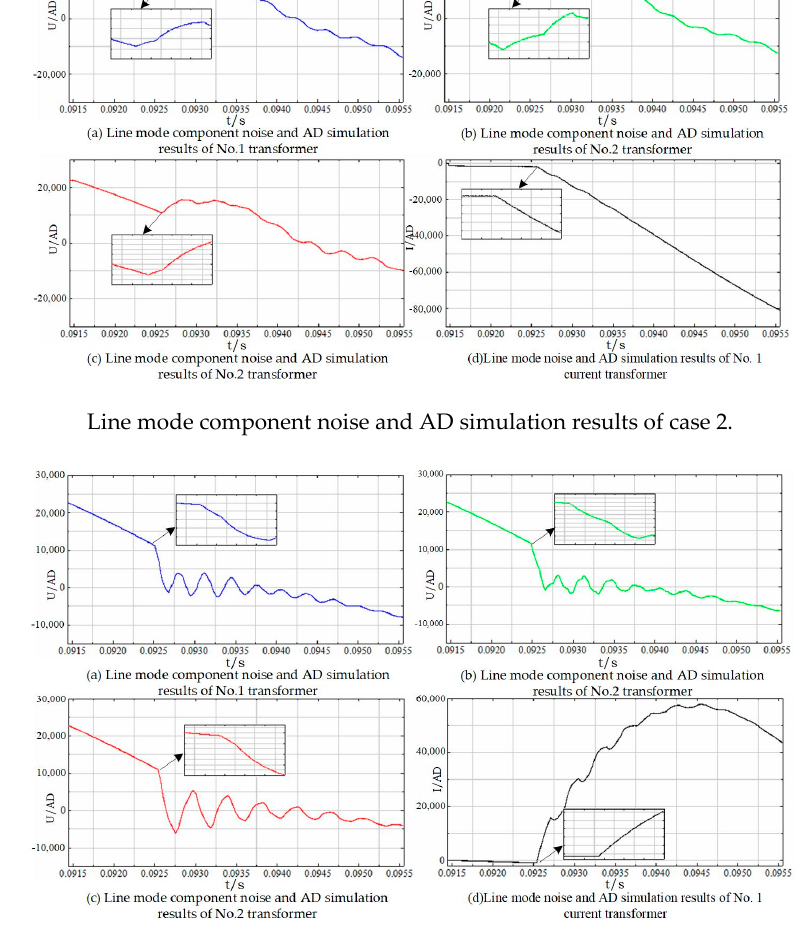
Figure 9. Line mode component noise and AD simulation result in different conditions.